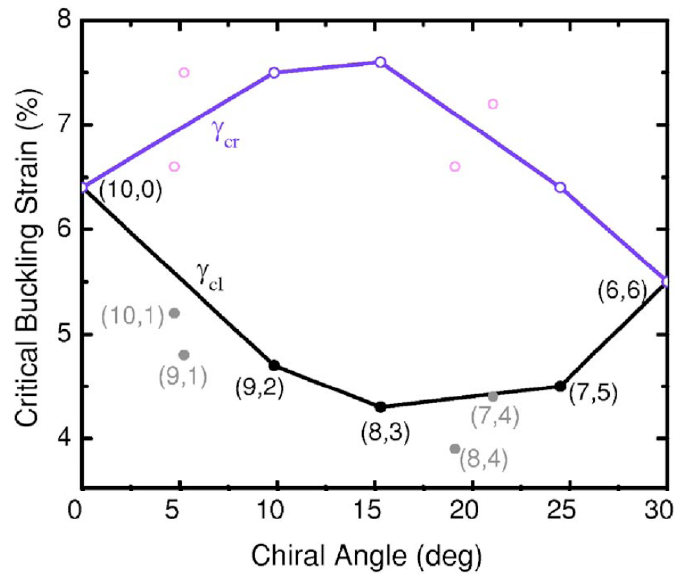
Figure 17. Critical buckling shear strains as a function of tube chirality. Some additional data for SWNTs with slightly larger or smaller diameters are also presented for reference. Reprinted from Reference